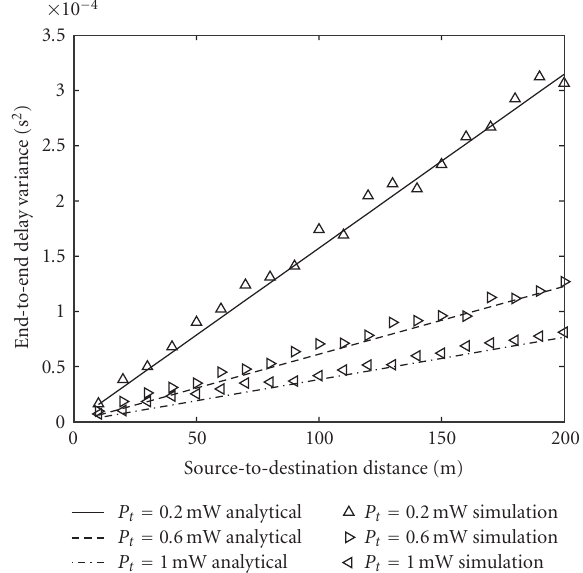
Figure 4: Throughput versus source-to-destination distance l ( λ = 0 . 1 / m 2 ).